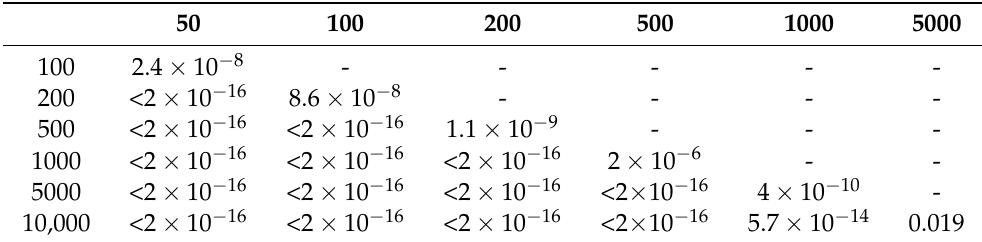
Table 4. Results of the Wilcoxon, Nemenyi, McDonald, and Thompson test to identify possible improvements associated with the generation of a greater number of solutions during the first phase of the analyzed